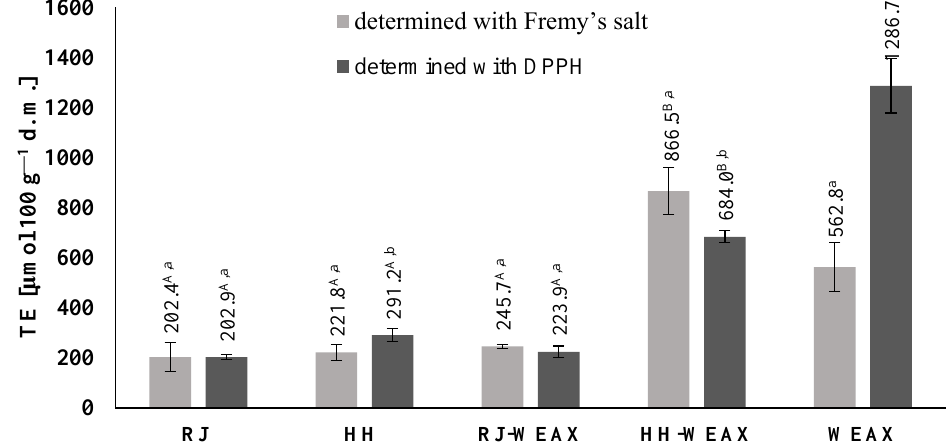
Figure 1. Antioxidant activity of encapsulated bee products analyzed by EPR spectroscopy. RJ-royal jelly; HH-honeydew honey; WEAX-water extractable arabinoxylans; TE-trolox equivalens. Uppercase letters followed by different letters indicate significant differences in antioxidant activity in the microcapsules obtained after spray drying bee products with WEAX depending on the type of the core material used for their preparation ( n = 3; p ≤ 0.05); lowercase letters followed by different letters indicate significant differences in antioxidant activity in the individual sample depending on the type of radical used in the assay ( n = 3; p ≤ 0.05); data are presented as mean ± SD. At the same time, a significant dependence of the antioxidant activity of the